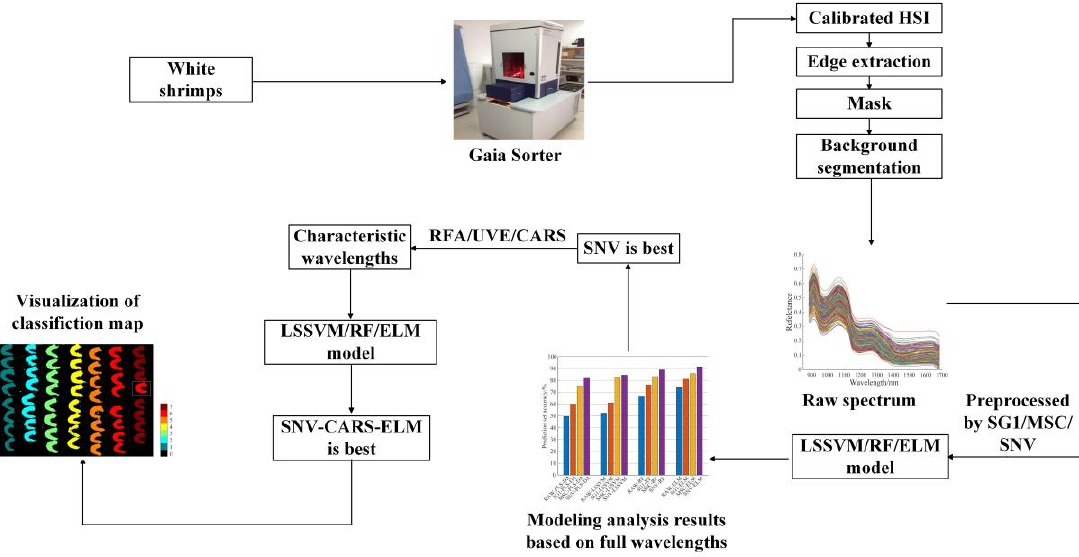
Figure 2. Main steps of extracting spectral data, characteristic wavelength, and establishing discrimination